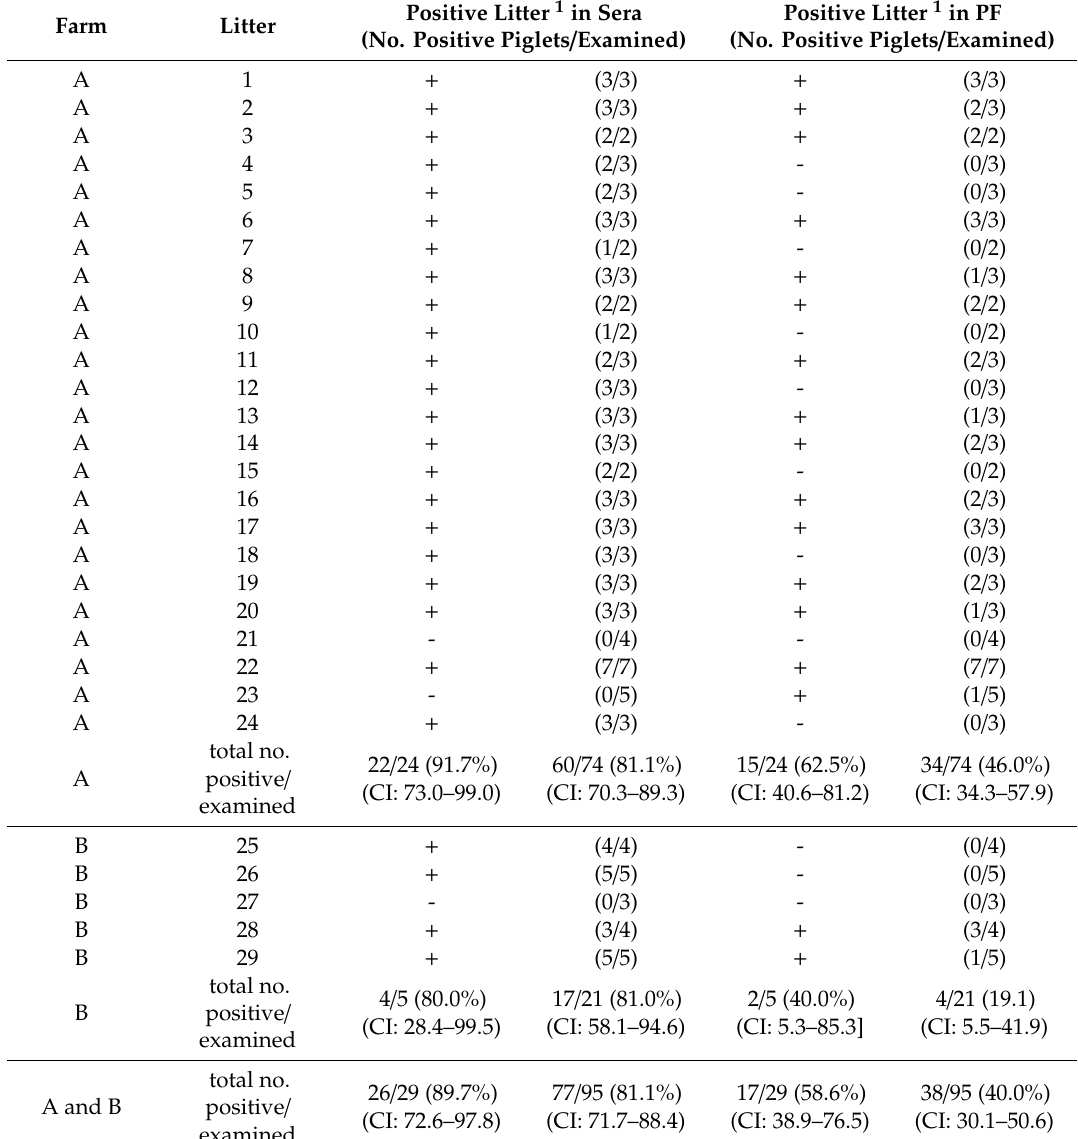
Table 1. Results of detection of anti-Hepatitis E virus (HEV) ELISA-positive litter in sera and processing fluids (PFs). Positive Litter 1 in Sera Positive Litter 1 in PF Farm Litter (No. Positive Piglets / Examined) (No. Positive Piglets / Examined) (3 /